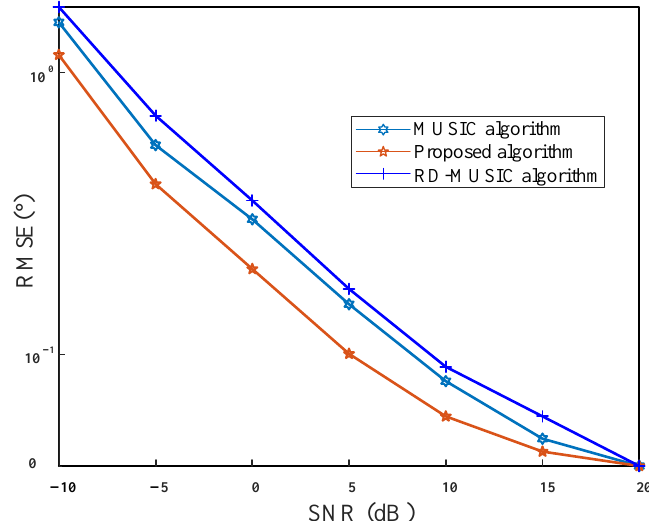
Figure 8. RMSE versus the SNR for theta.